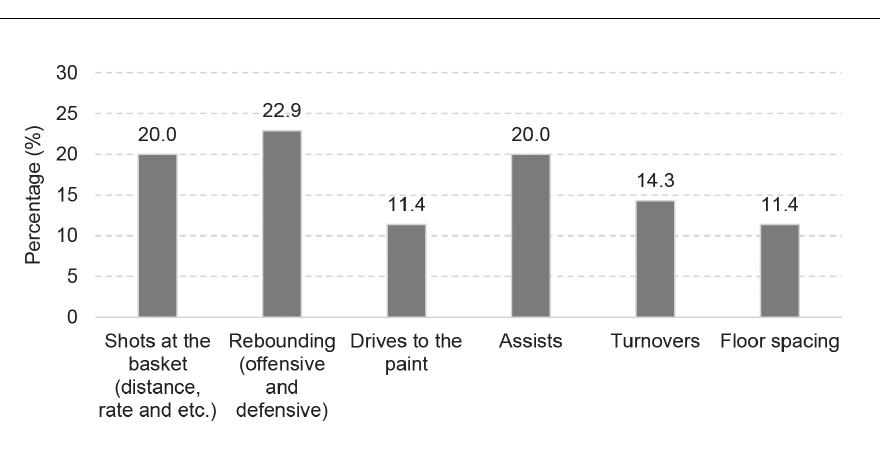
Figure 2. Indicators to be analysed